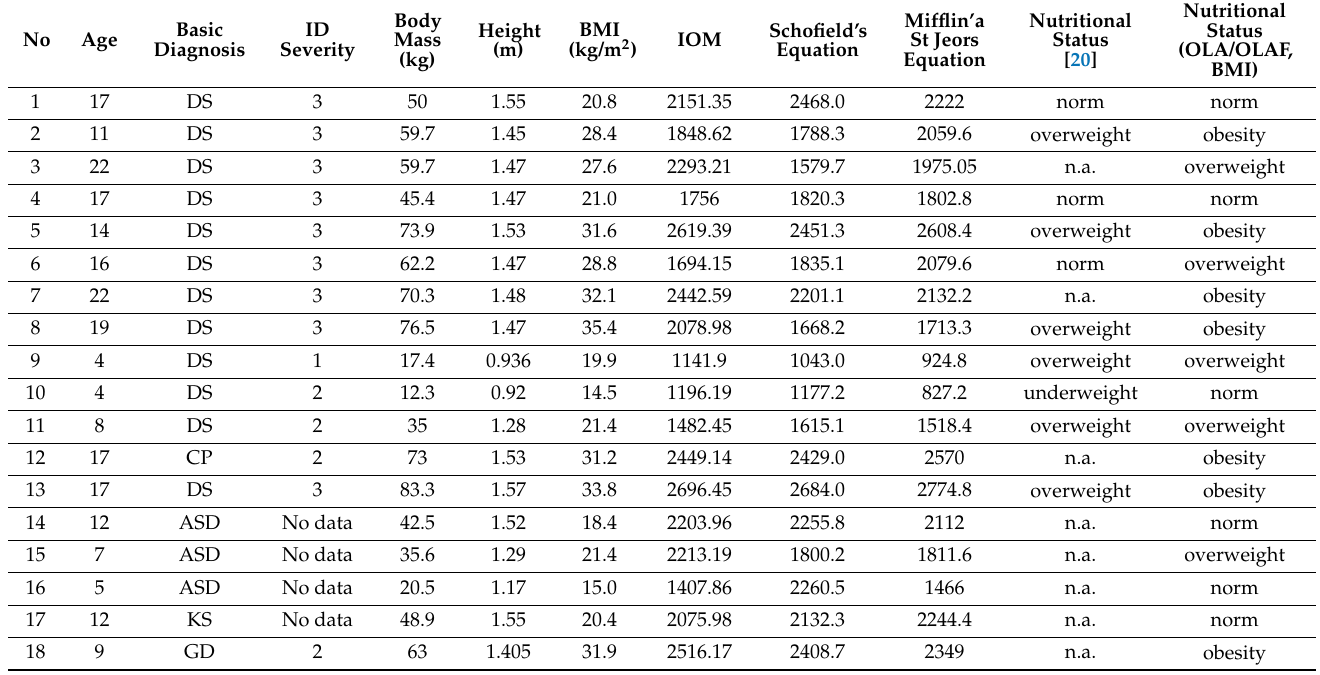
Table 2. Nutritional status in the studied group in relation to the total energy requirement.